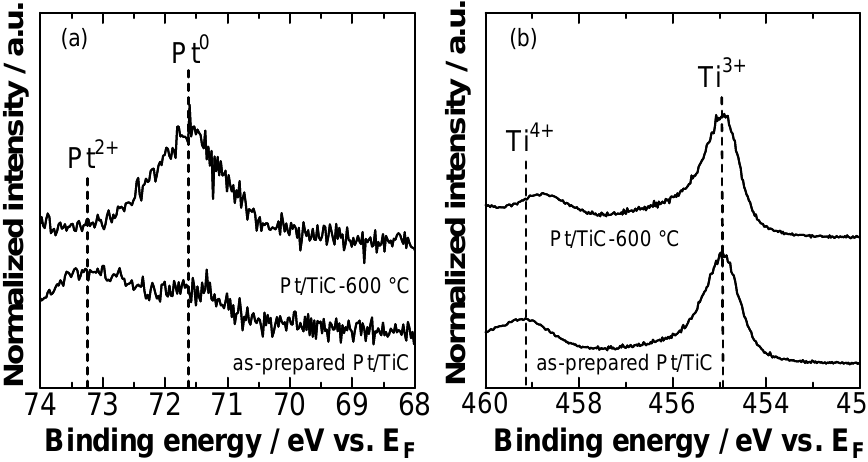
Figure 2. X-ray photoelectron spectra of as-prepared Pt/TiC and Pt/TiC-600 °C in the binding energy regions of ( a ) Pt 4f 7/2 and ( b ) Ti 2p 3/2